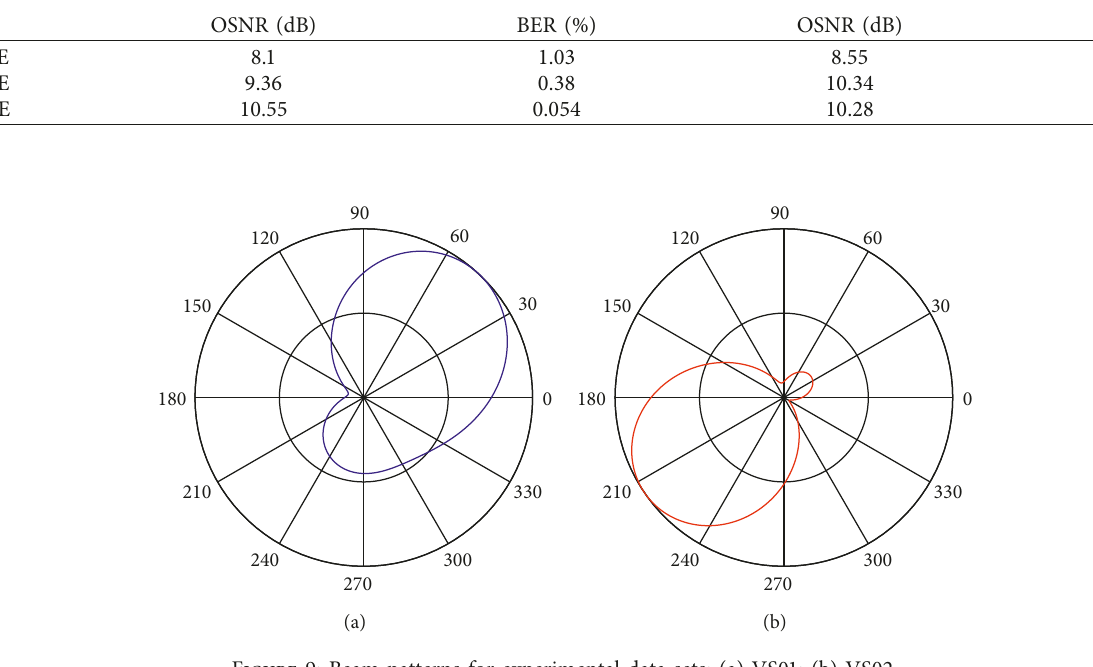
Figure 9: Beam patterns for experimental data sets: (a) VS01; (b) VS02.